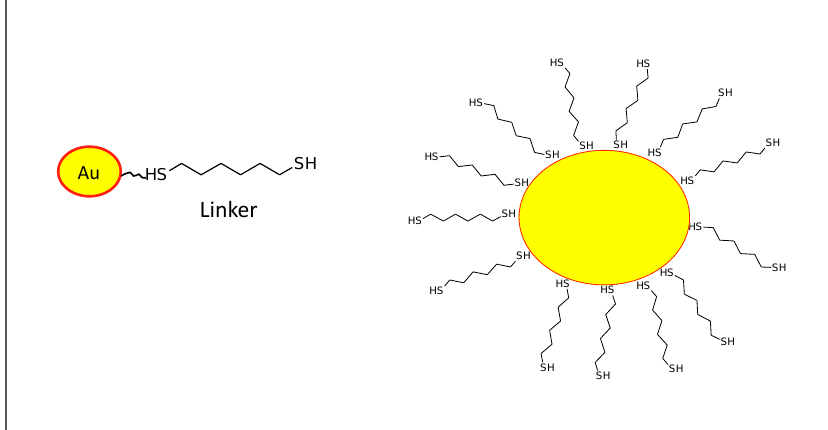
Figure 6. Schematic representation of gold (Au) nanoparticle modified with likers on the surface for further functionalization (right). Au Core (yellow) conjugated with a dithioether linker (left).